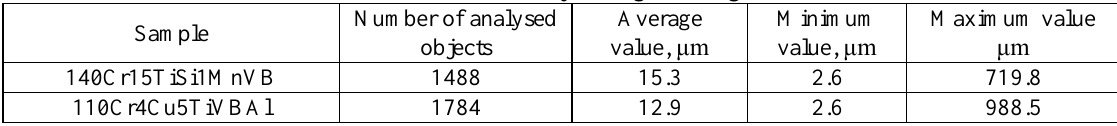
The results of the analysis of grain length